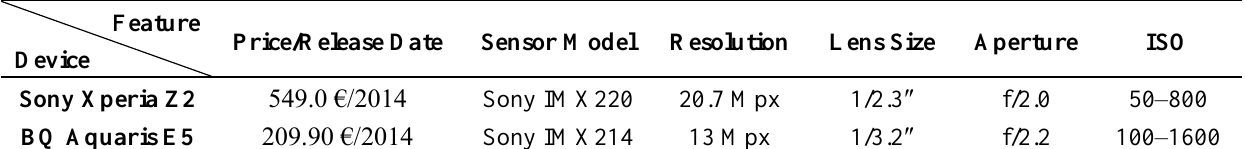
Table 1. Main relevant features of the 2 devices used for evaluating the performance of the vitisFlower